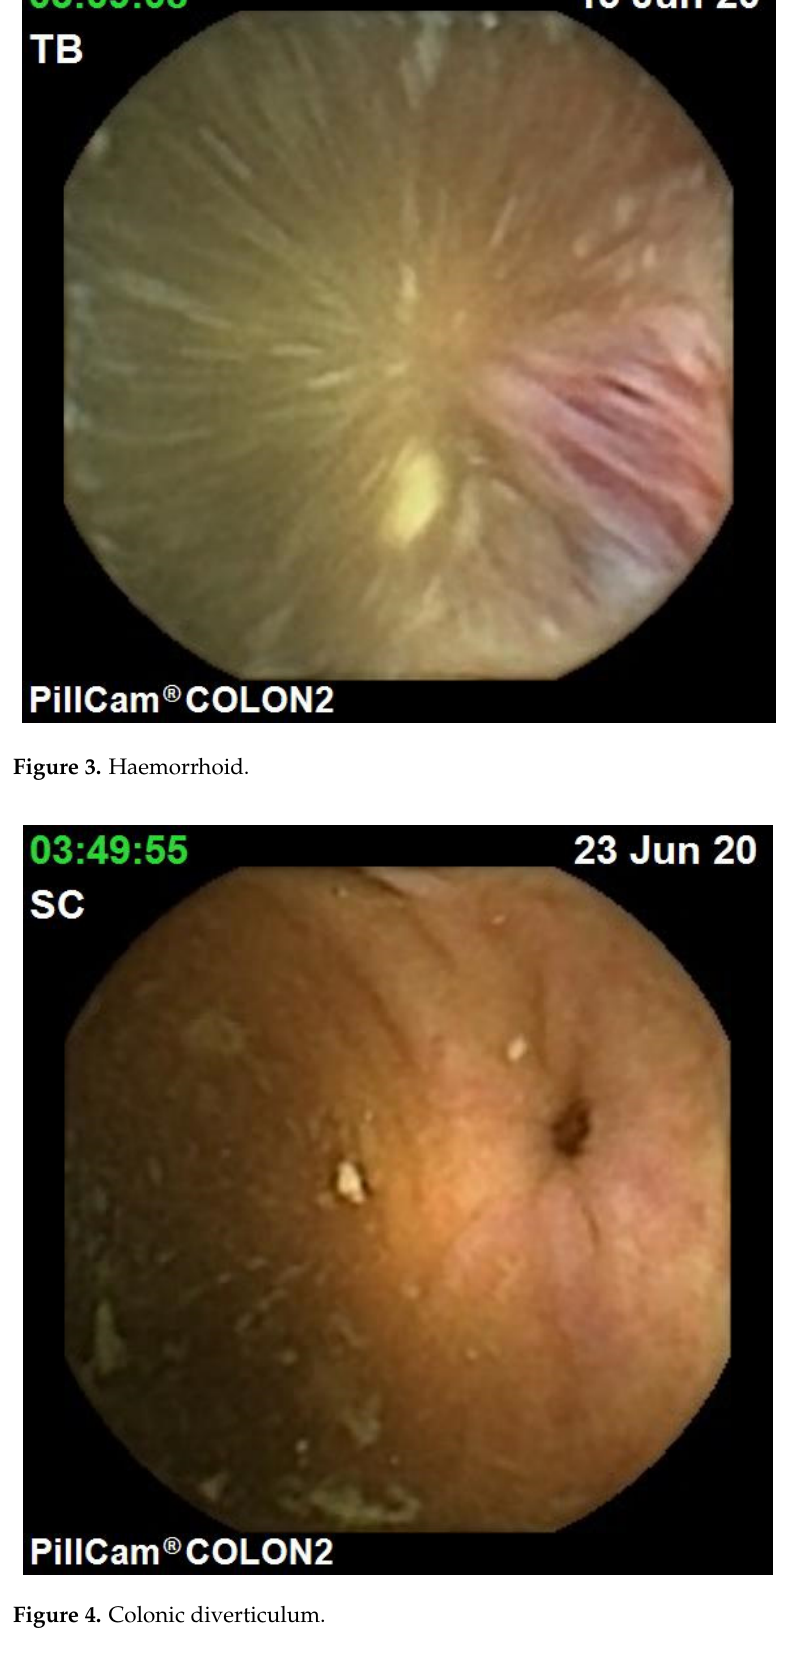
Figure 4. Colonic diverticulum.